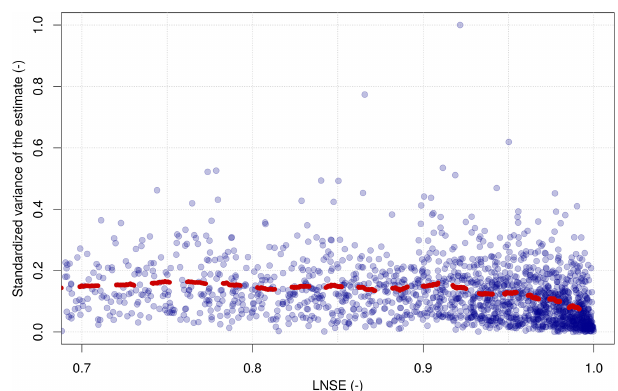
Figure 6. Standardized prediction variance of TNDTK as a func- tion of LNSE. LNSE values smaller than 0.7 are omitted here. The red dashed line represents the moving average computed with a moving window of 150 catchments. Note that, for the 2484 high- quality stream gauges, only 2102 LNSE values are